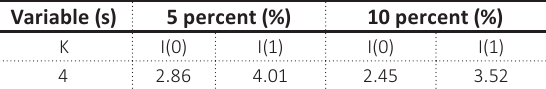
Table 4. ARDL bound test for